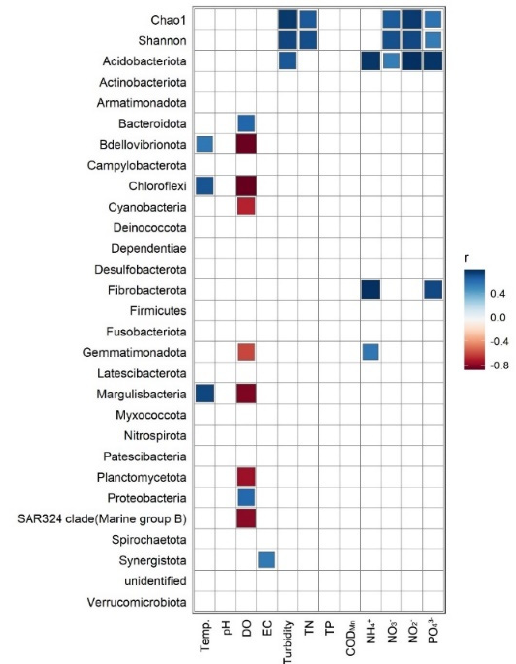
Figure 7. Correlation between environmental variables and the relative abundance of bacterial phyla and alpha diversity indexes.